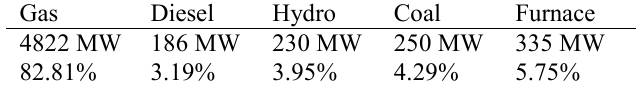
Table 2: Different fuel Consumption Table 3: Authorities of Power Generation and Capacities and